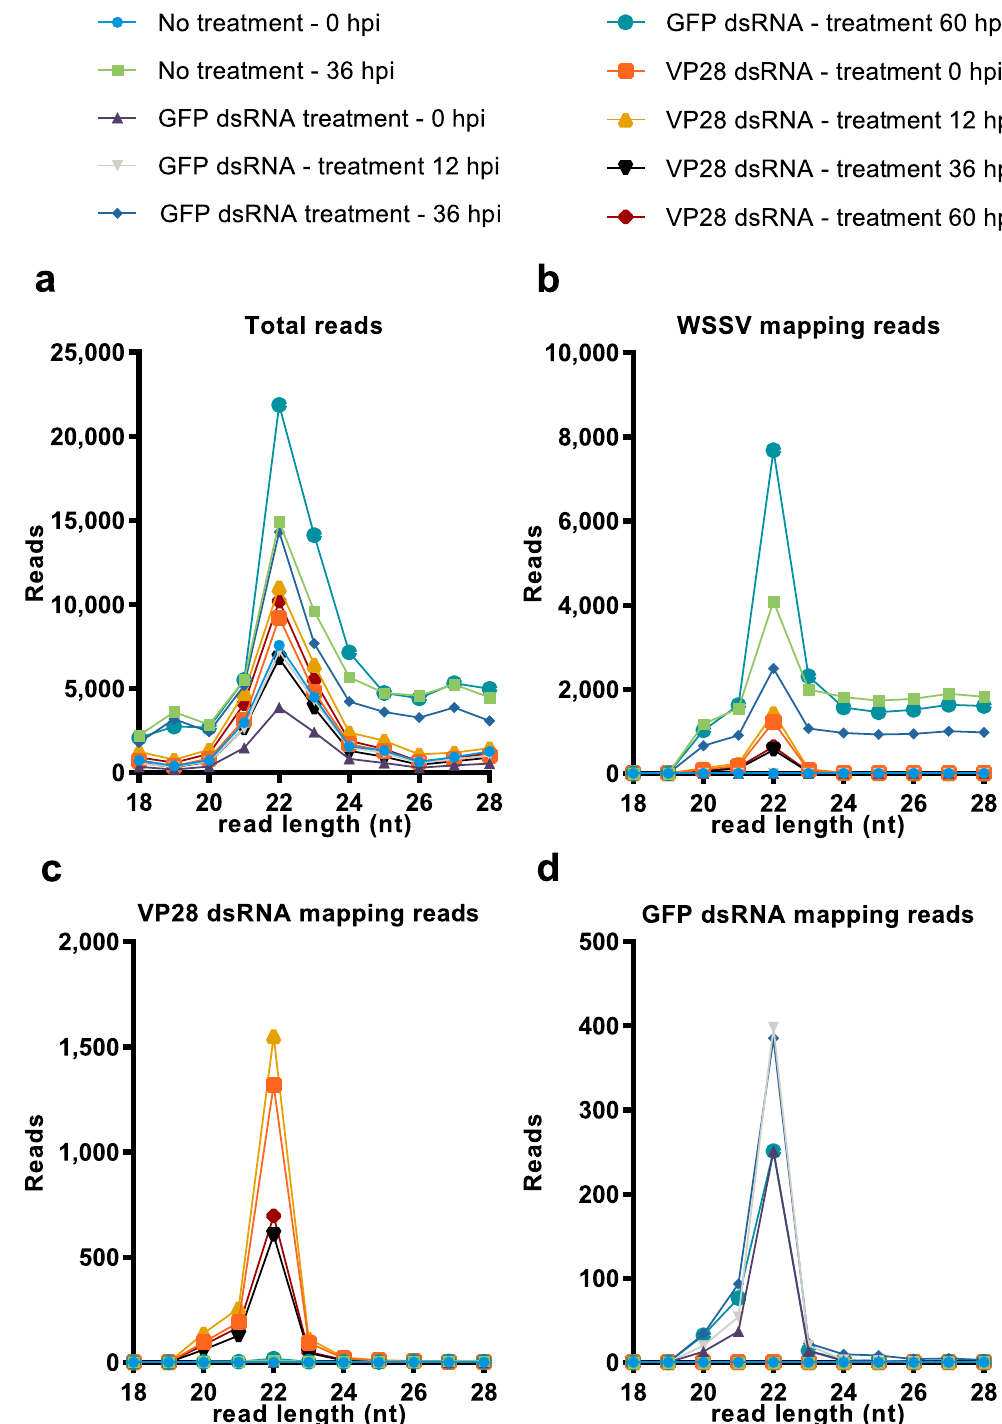
Figure 8. Small RNA length distribution. RNA was isolated from individual shrimp’s stomach tissue, and was pooled in equal amounts by group for given time points. RNA sequencing was performed on these pools and obtained data was subjected to an analysis of read length distribution frequency. ( a ) Represents read length distribution frequency among total reads obtained for each sample, ( b ) represents read length distribution frequency among reads mapping to a WSSV reference genome, ( c ) represents read length distribution frequency among reads mapping to the VP28 dsRNA treatment sequence, and ( d ) represents the read length distribution frequency among reads mapping to the GFP dsRNA sequence. The Y-axis represents reads per million total reads for a given sample